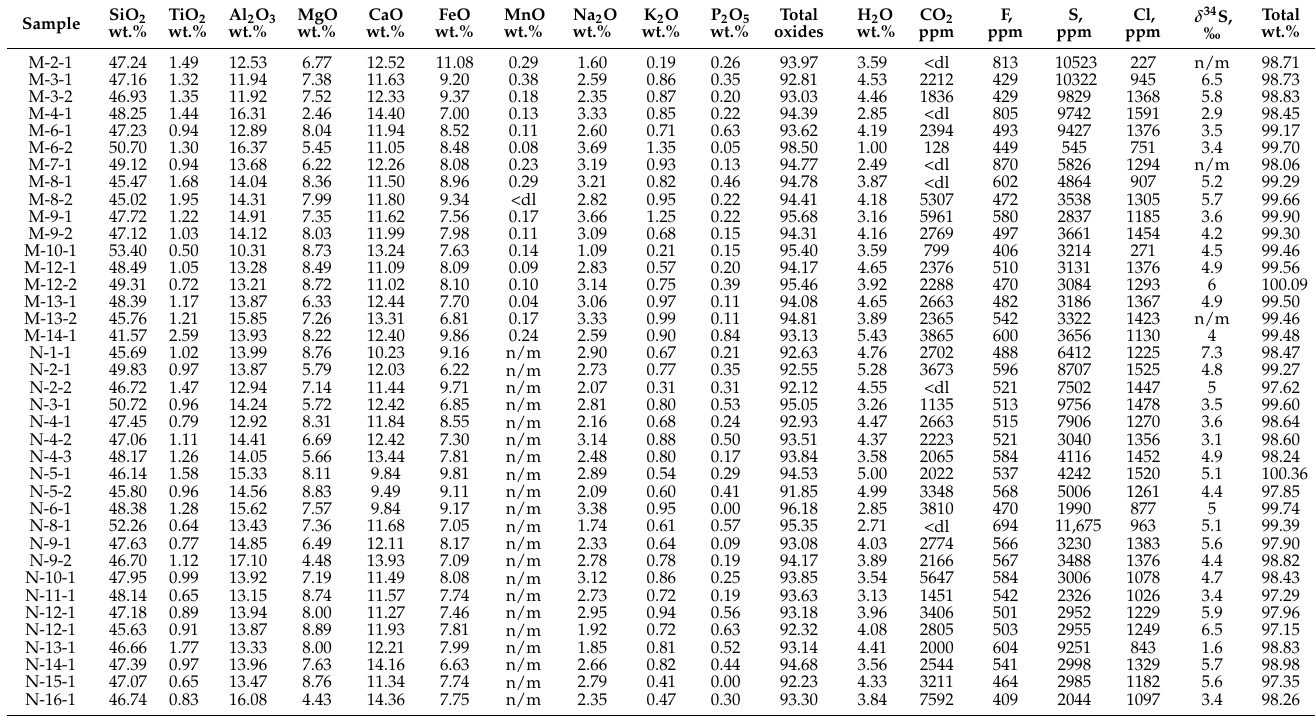
Table 1. Chemical composition of olivine-hosted melt inclusions,